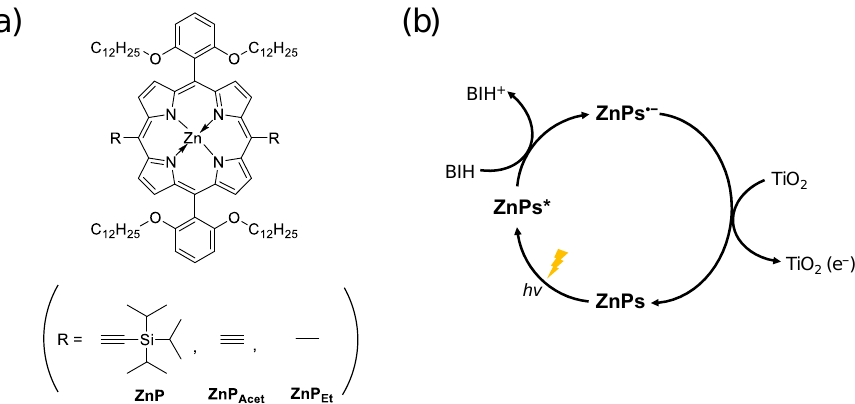
Figure 1. ( a ) Molecular structures of ZnPs and ( b ) electron pathways investigated in this study.